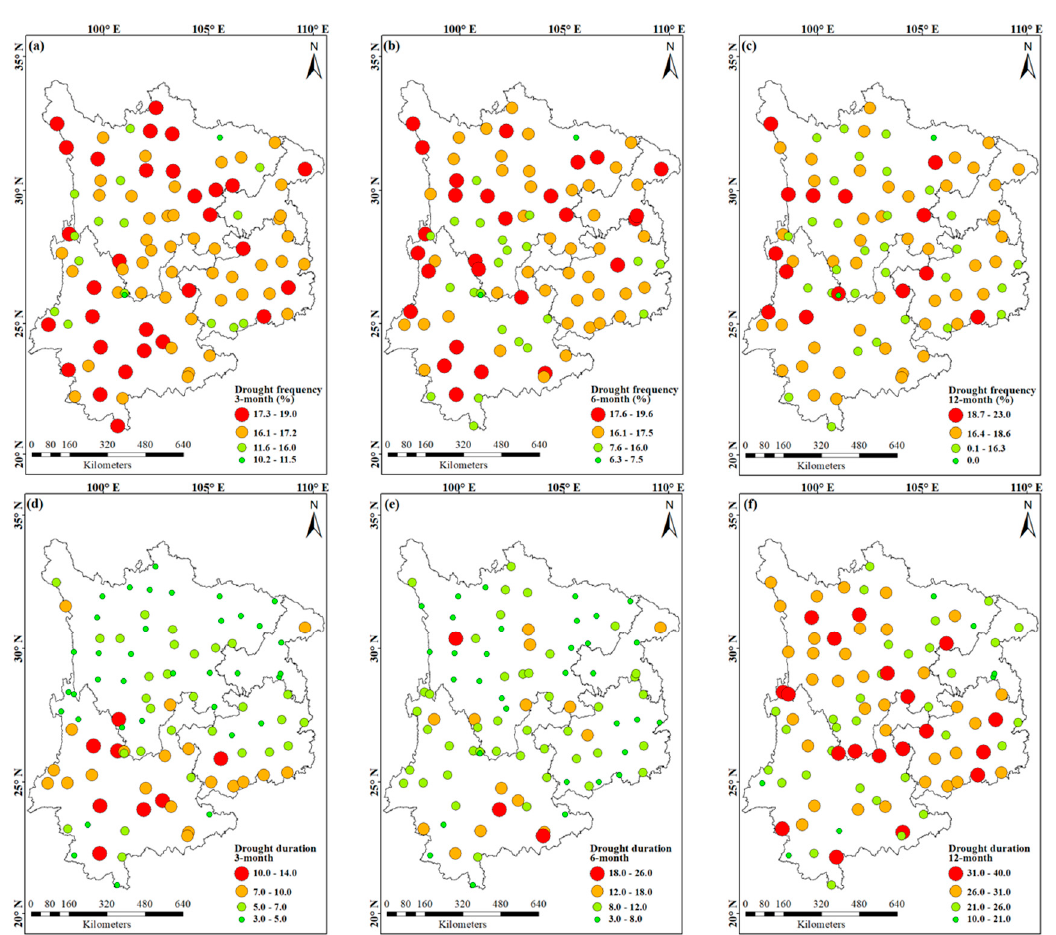
Figure 5. Spatial distribution of drought frequency ( a – c ) and duration ( d – f ) with 3-, 6-, and 12-month timescales over Southwest China from 1960 to 2017.